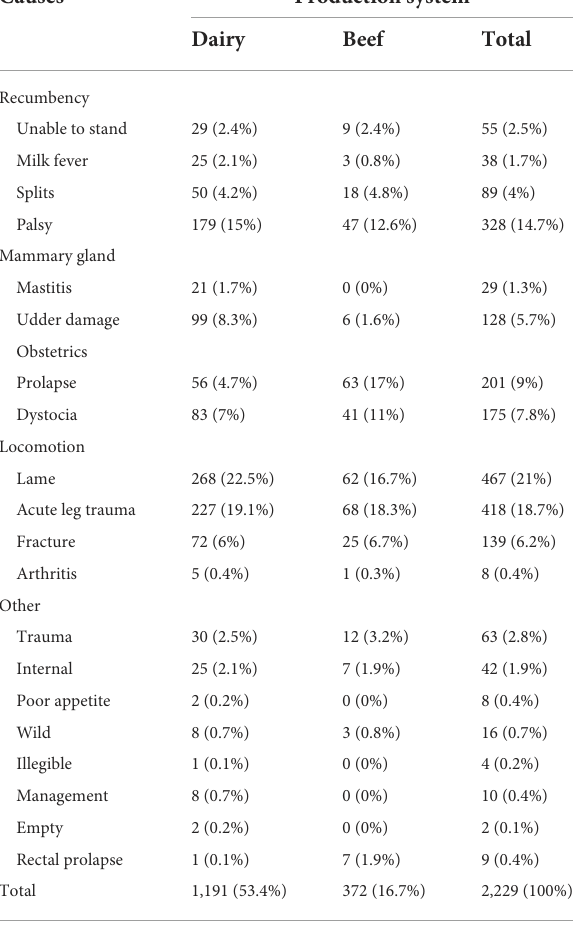
TABLE 3 Descriptive table showing number and percentage of total of each production system within each subcategory for OFES. Causes Production